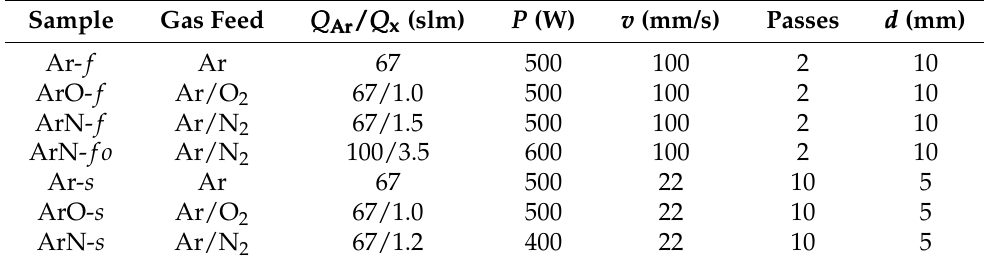
Table 1. PP samples treated by RF plasma slit jet used in the gas feed comparison: Q Ar denotes Ar flow rate, Q x is the flow rate of the additive gas (oxygen, nitrogen), P is the RF power, v is the treatment speed, and d is the distance between the slit exit and the sample surface. The letters f or s in the sample name denote a faster or slower treatment speed, respectively, and fo is used for the optimized conditions at the faster treatment speed. Samples were treated two or ten times